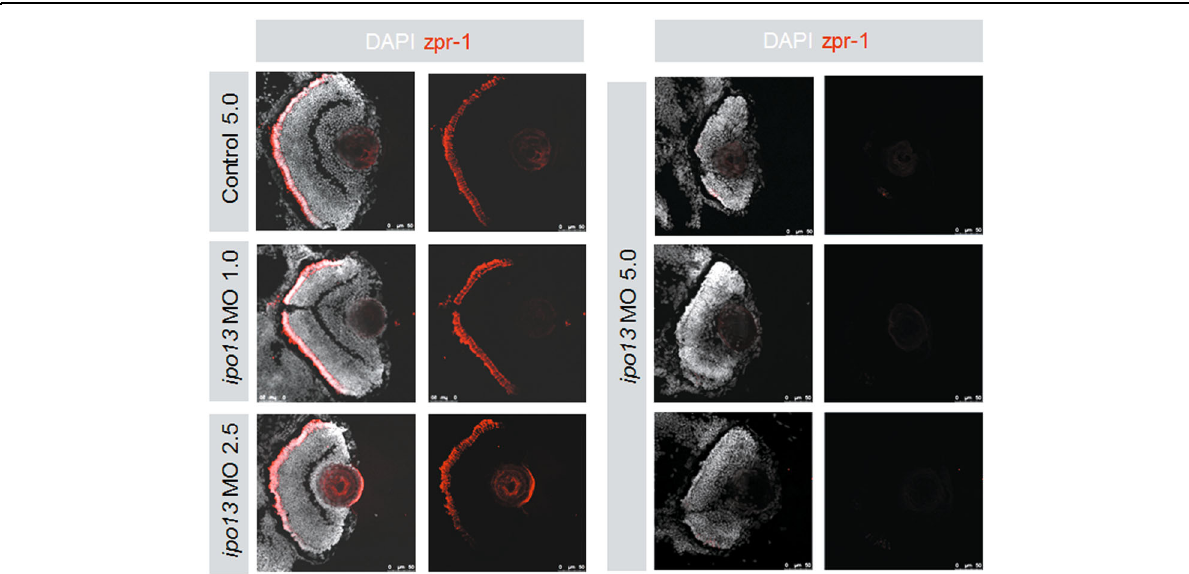
Fig. 4 Retinal architecture of ipo13 -de fi cient morphants. Left panel shows the control MO 5.0 ng, ipo13 -MO 1.0 ng, and ipo13 -MO 2.5 ng injected larvae expressing zpr-1 in relative normal levels at 3 dpf. Less zpr-1 signal is detected in the peripheral area of larval retinas. The three nuclear layers are even in these three groups. Right panel shows that ipo13 -MO 5.0 ng injection disturbs the lamination of retinal nuclear layers. Both plexiform layers are not observed in this group, and almost no zpr-1 expression is